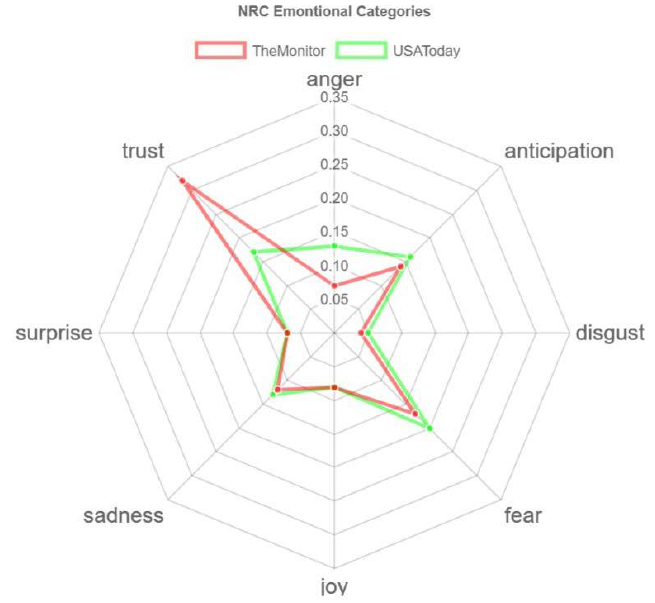
Figure 11. A radar chart of emotional valence.